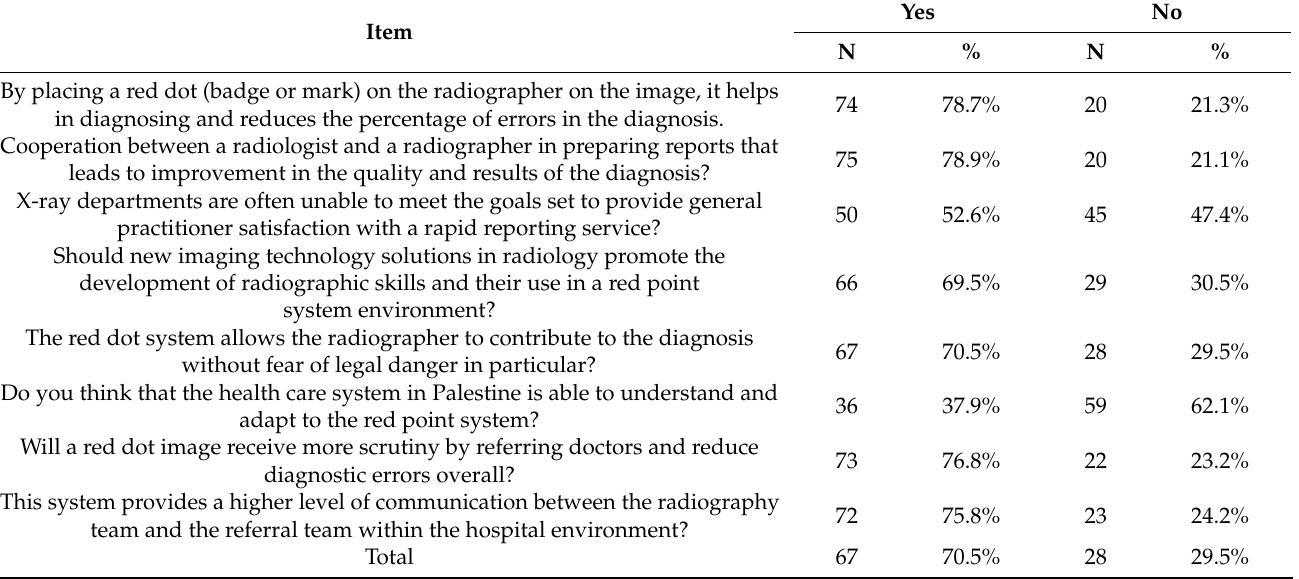
Table 4. Frequencies and percentages of radiologists and radiographers toward the effects and results of adding the red dot system (n =